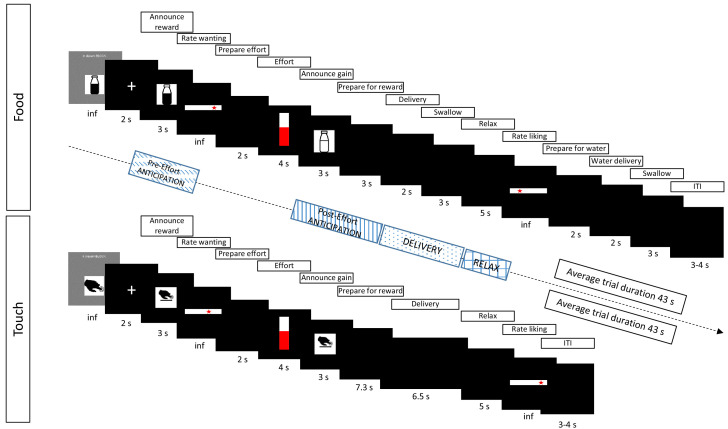
All trial elements.